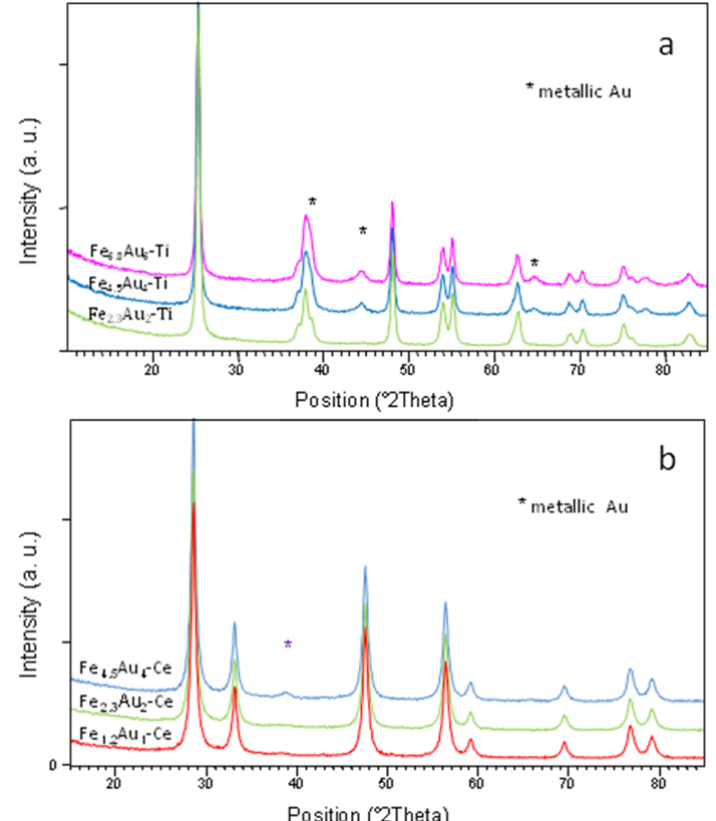
Figure 6. XRD patterns of bimetallic titania ( a ) and ceria ( b ) catalysts prepared with [NEt ][AuFe (CO) ]. 4 4 16